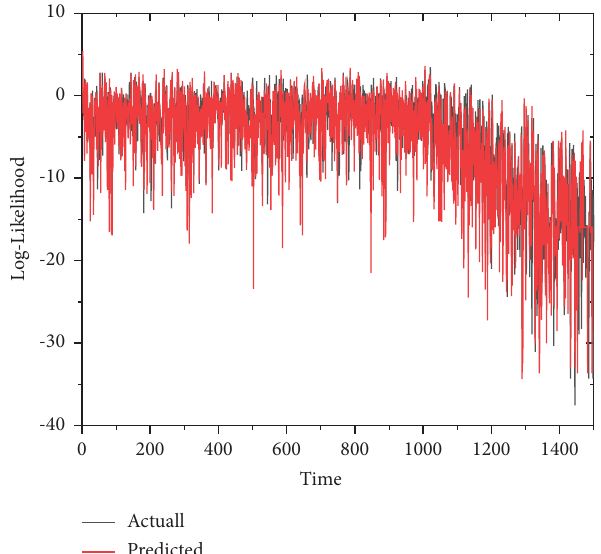
Figure 11: Detection and prediction result of E feed lose fault.